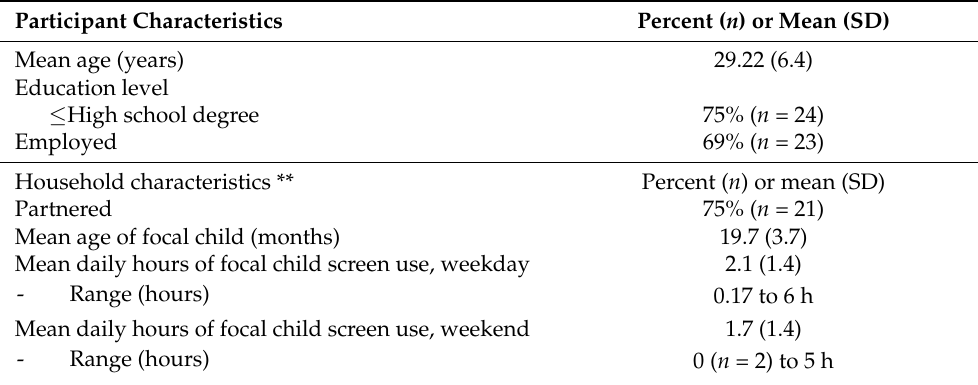
Table 1. Participant Demographics and Interview Characteristics for In-depth Interviews with Mexican American Parents of Toddlers ( n = 32 Participants) *.